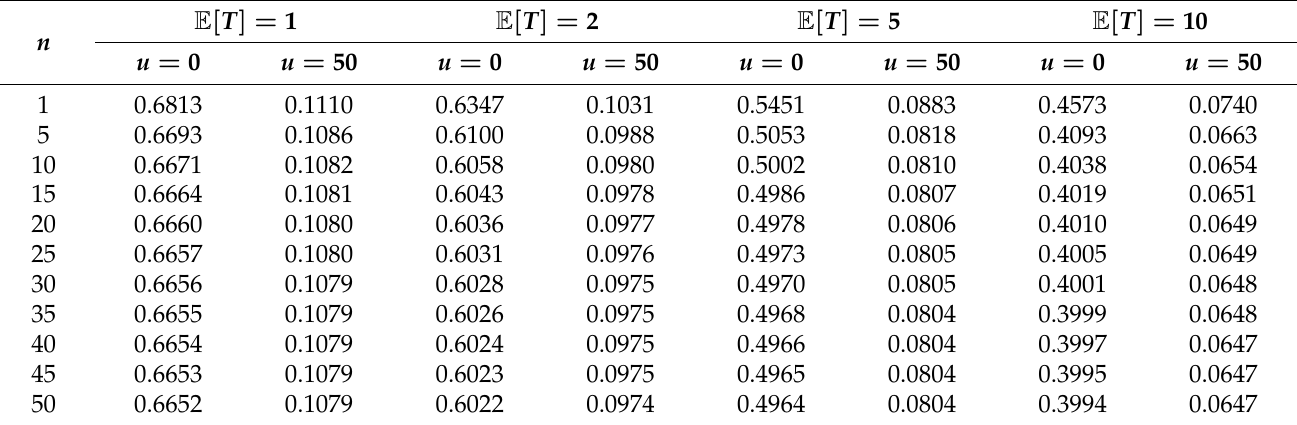
Table 3. Modified Parisian ruin probabilities when claims are a sum of exponentials.